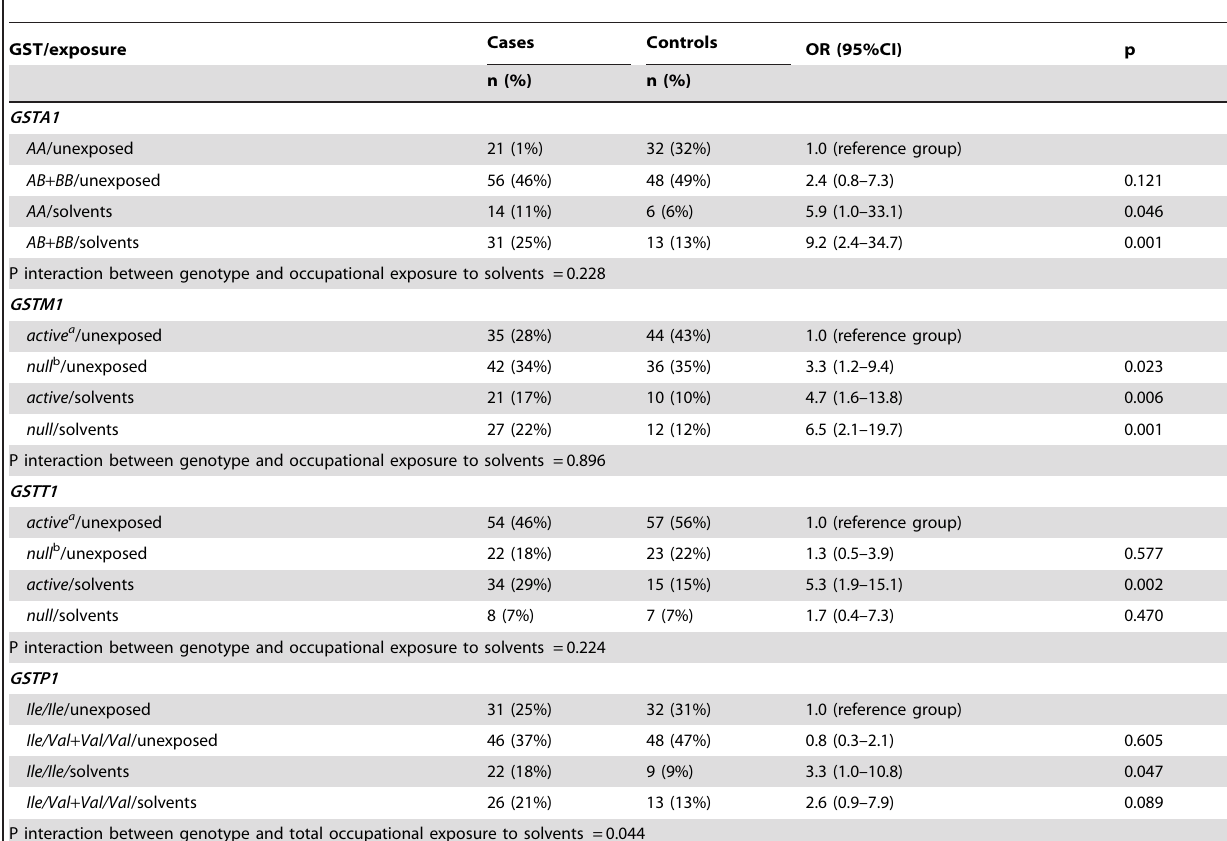
Table 4. Combined effect of occupational exposure to solvents and GST genotype on bladder cancer risk in male patients.